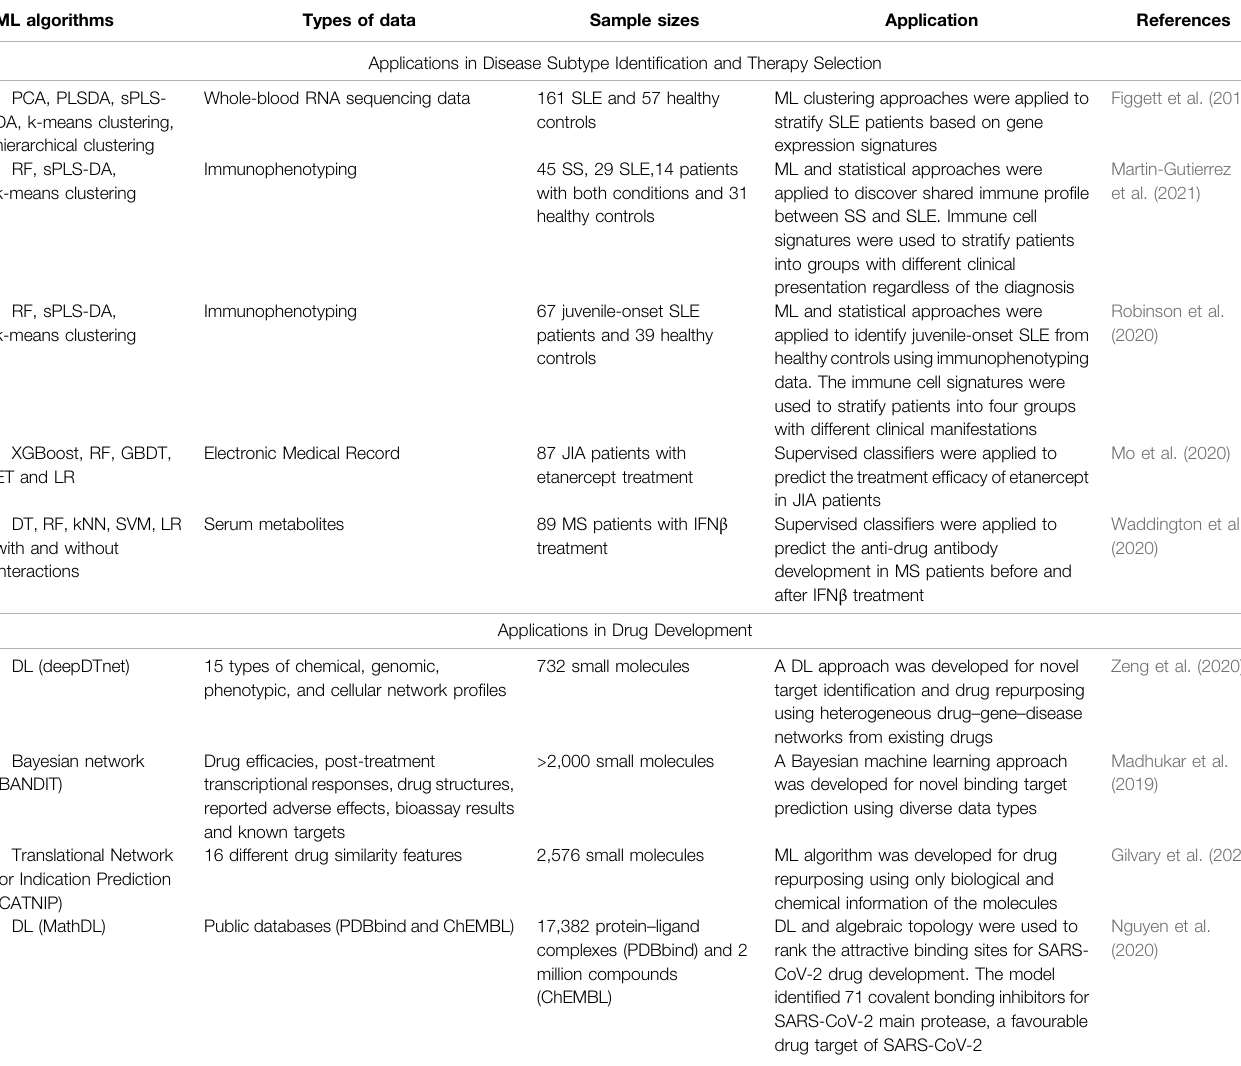
TABLE 2 | Examples of machine learning application in subtype identi fi cation, therapy selection and drug development of in fl ammatory diseases. ML